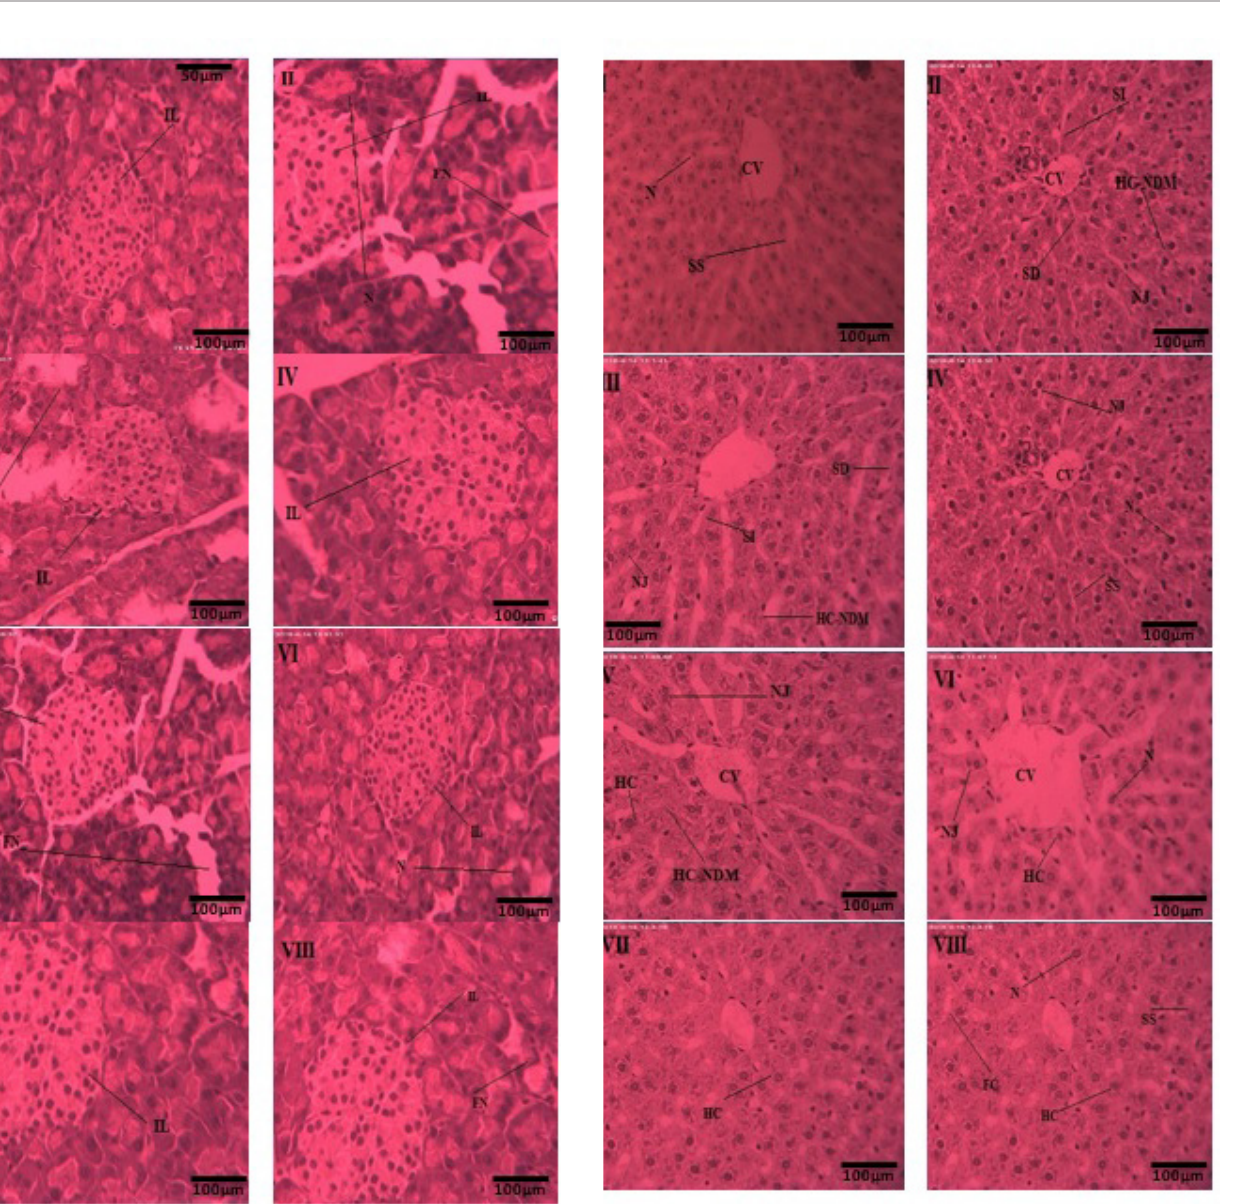
FIGURE 5 - Histology of the liver. (I) normal control, (II) diabetic control, (III) HNC, (IV) HNN, (V) HNE, (VI) HNA, (VII) lupeol and (VIII) glibenclamide. Samples were magnified at 40X and “CV” is central venule (CV), “HC” hepatocytes, “SS” sinusoidal space, “SD” is sinusoidal dilution, “SI” is scattered inflammation, “HC-NDM” is non-demarcated hepatocyte, “NJ” is nuclear joining and “N” is